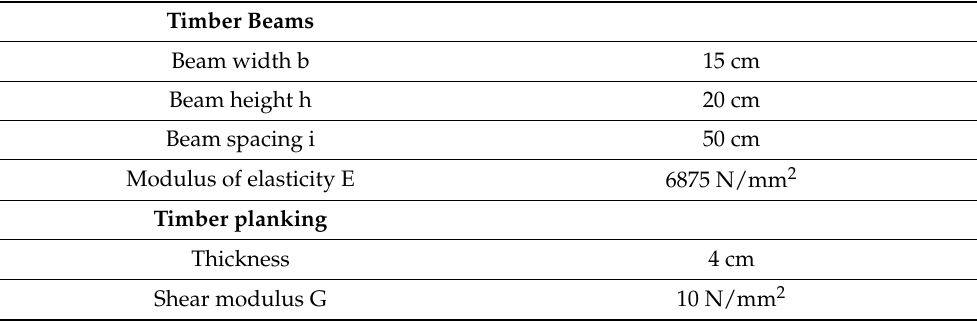
Figure 1. ( a ) North-east facade ( b ) south-east facade ( c ) south-west facade and ( d ) timber floor dia- phragm of the building. Table 1. Floor system consisting of timber beams with wooden planking. Table 1. Floor system consisting of timber beams with wooden planking.